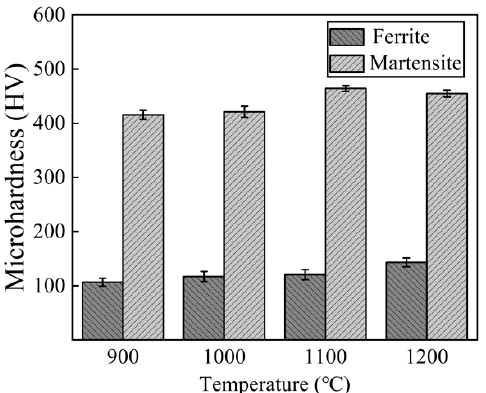
Figure 7. Microhardness of the experimental steel after solution treatment at different tempera ‐ tures.